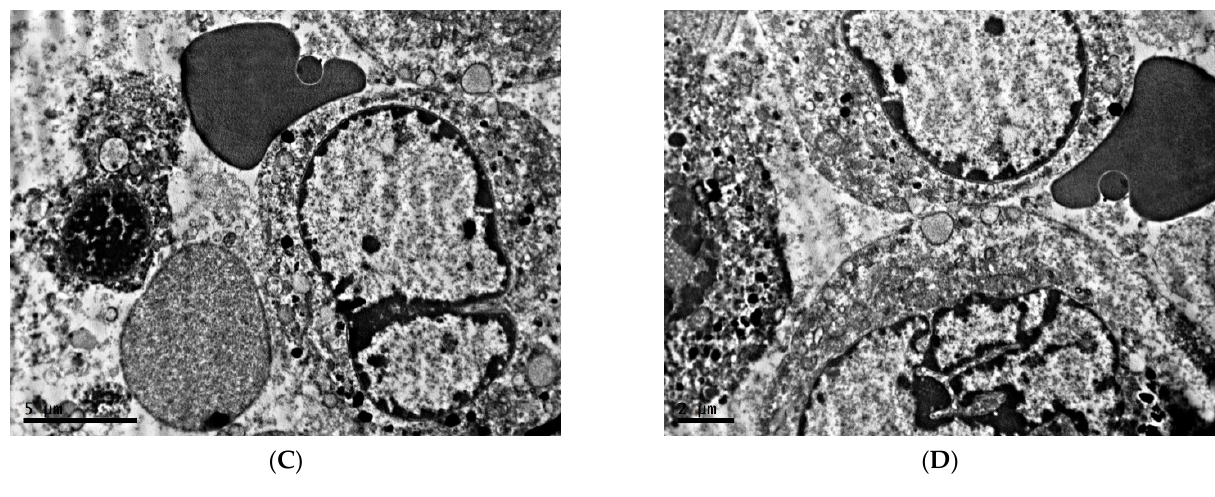
Figure 7. Characteristics of nuclei of cells of transplantable malignant melanoma B16 under the influence of constant lighting. TEM, ( A , D )—×10,000, ( B )—×6700, ( C )—×8000. A significant number of ribosomes are observed. The endoplasmic reticulum is weakly expressed or vacuolated. The Golgi complex is poorly developed. In contrast to the cells of the first experimental group, in this group, there is practically no content of lipid vacuoles in the cells. The content of mitochondria in tumor cells in this group is higher than under fixed lighting. Mitochondria are smaller, with denser matrix and significantly greater number of cristae than was noted for the control group (Figure 8).